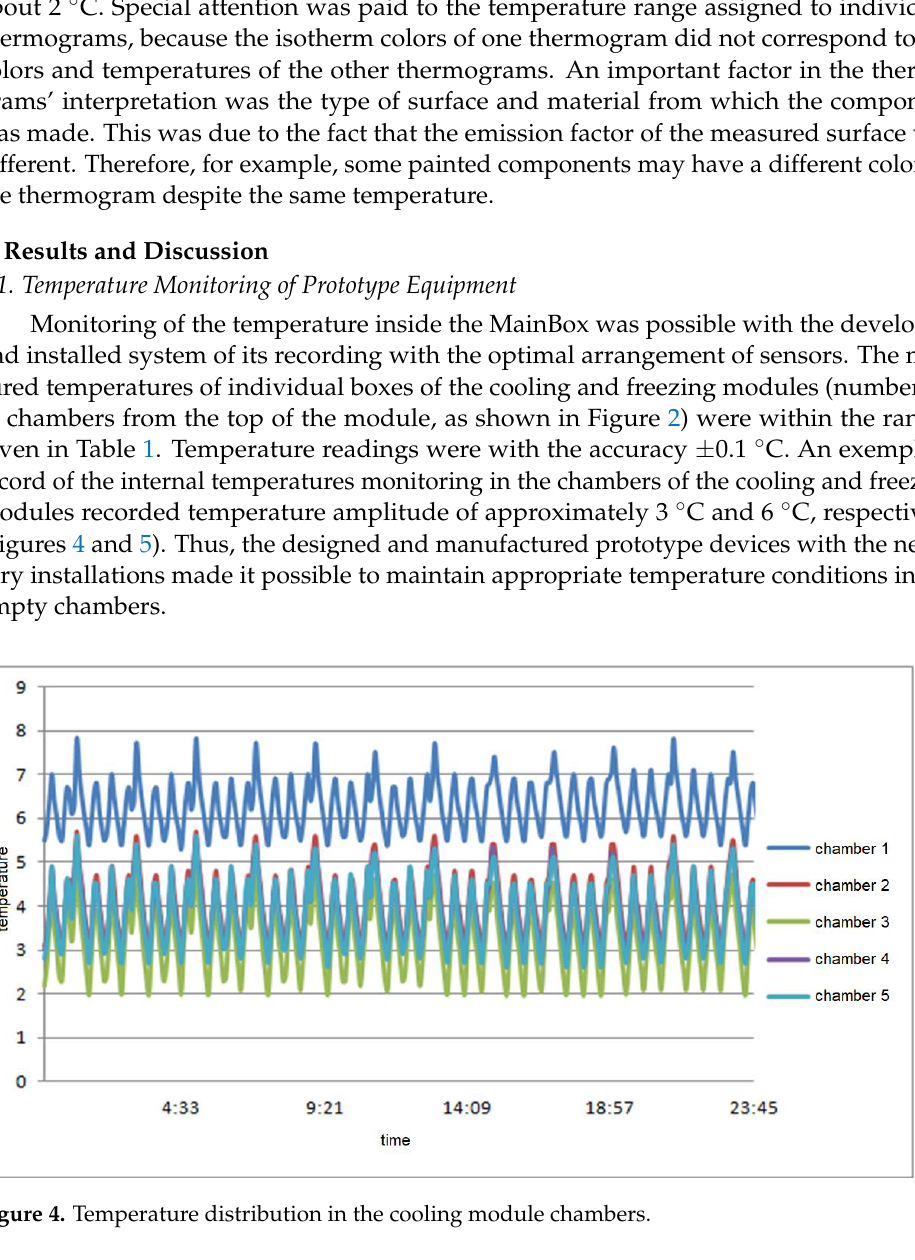
Figure 5. Temperature distribution in the freezing module chambers . The analysis of the storage conditions of food products in all chambers of the cooling and freezing module was carried out over a period of approximately 48 h, starting from the loading with food products to emptying them. In both prototypes, optimal storage conditions were maintained in each box during loading (Tables 2 and 3). Smaller temper- ature fluctuations occurred in the chambers during the unloading of products, both in the cooling boxes (Figure 6) and in the freezing boxes (Figure 7). In the case of the freezing module, temperature differences of approximately 7 °C were identified. The minimum freezer storage ranges (below − 18 °C) were achieved. The temperature data showed that relatively stable temperatures were maintained for 48 h during storage.